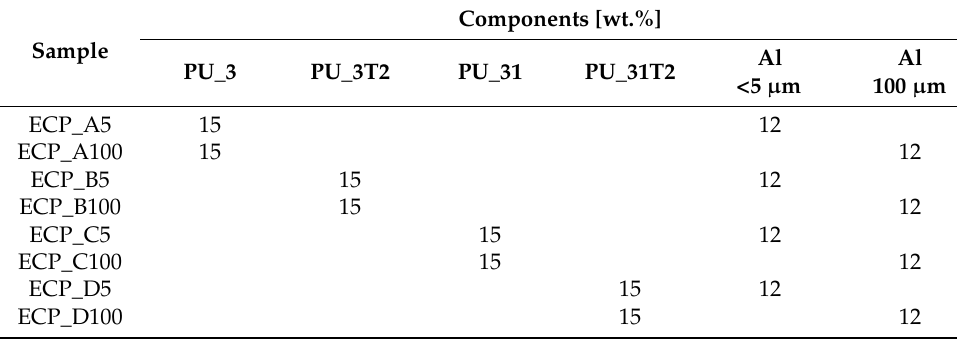
Table 3. Formulations for the rocket propellant composite.